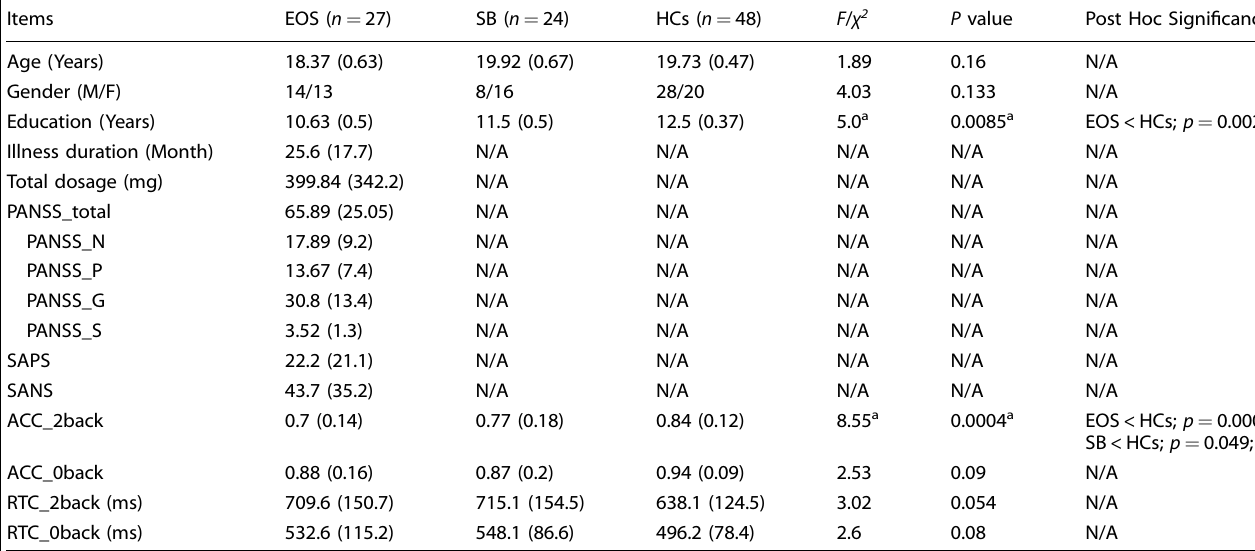
Table 1. Demographic, neuropsychological, and clinical